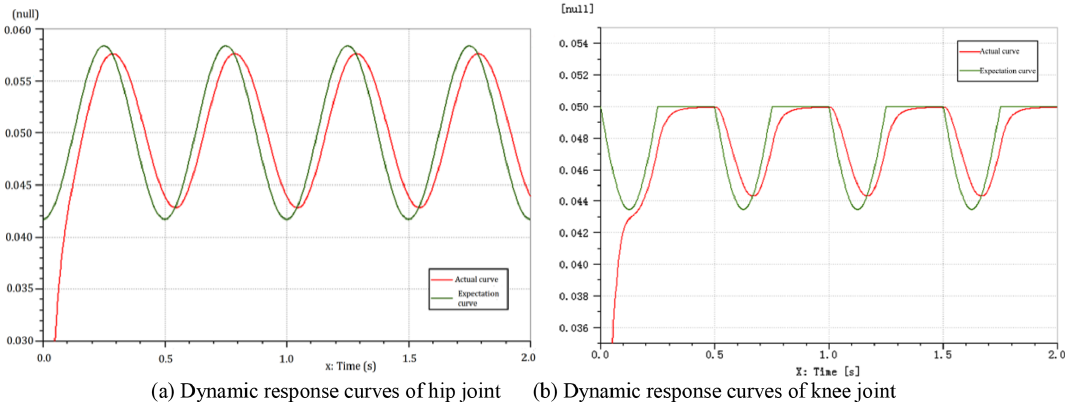
Figure 14. Comparison of dynamic response curves of actual and expected positions of hip and knee joints.